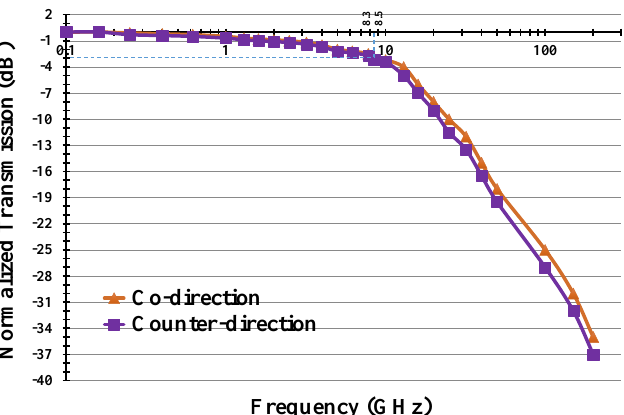
Figure 4. Dynamic characteristic of the SOA-MZI with the bandwidth of 8.5 GHz for the co-direction and 8.3 GHz for the counter-direction.